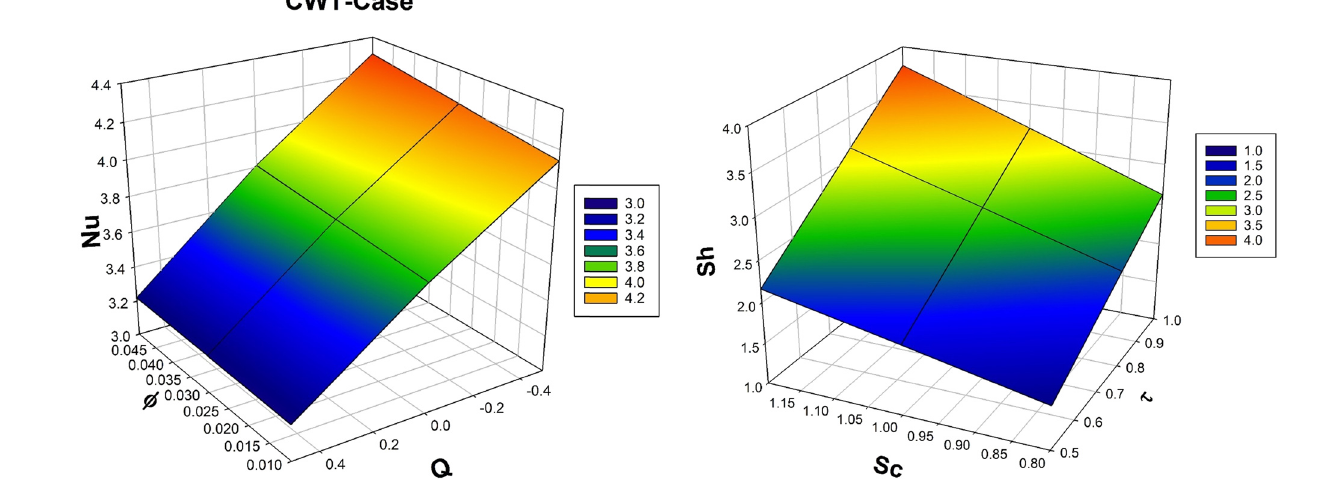
Figure 14: Change in Sh against Sc for heightening of τ . Figure 12: Change in Nu against Q for heightening of ϕ ( CWT case ) .